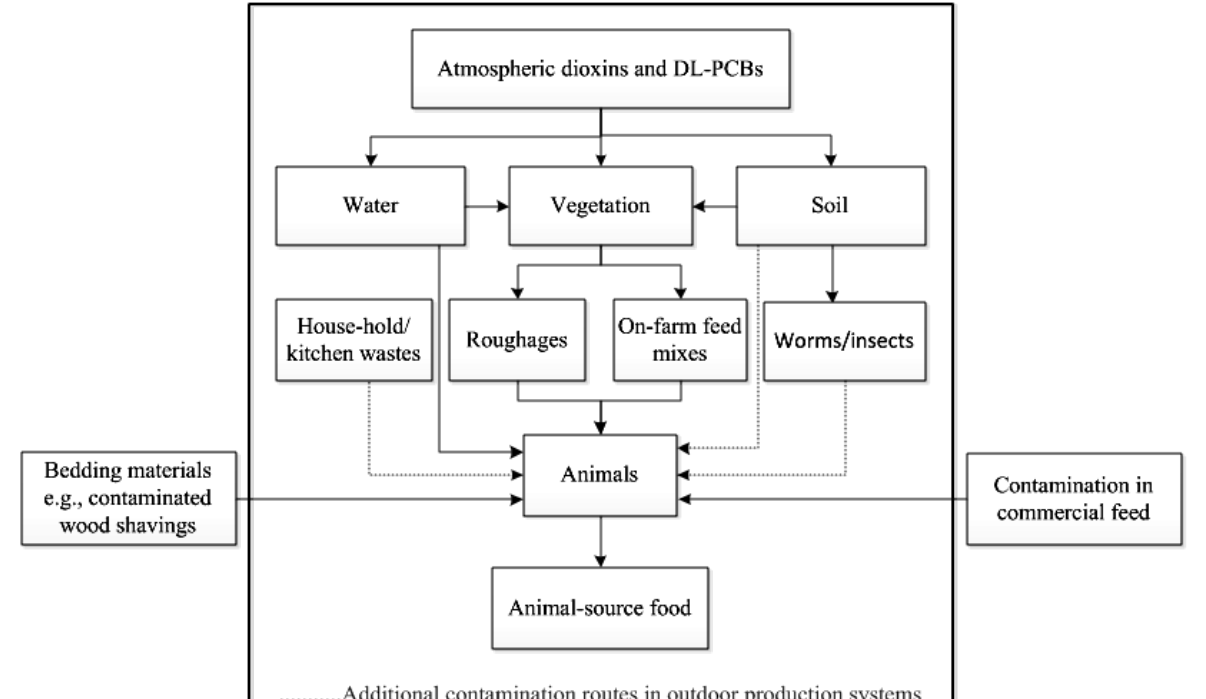
Figure 2. Possible contamination routes along the food chain of animal-source